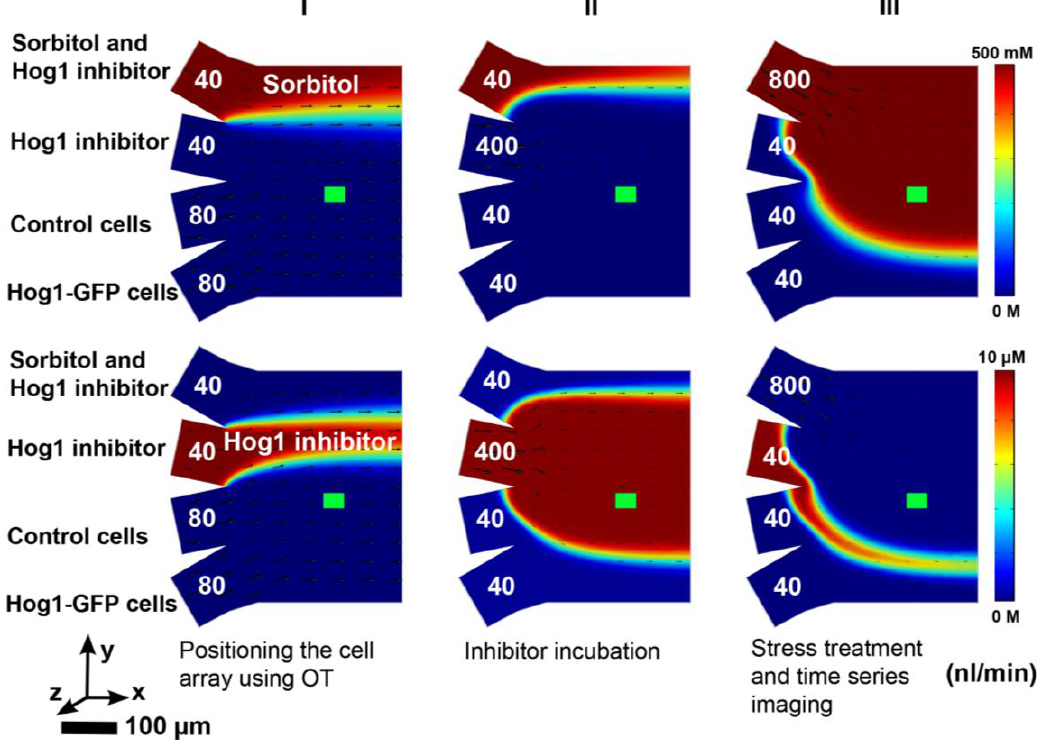
Figure 4. Simulation data on concentrations and flow velocities in the microfluidic chamber are shown. The arrow lengths are proportional to the flow velocities given at half of the channel height (a distance of 13.5 μm from the bottom surface). The concentration distribution is given at a distance of 0.1 μm from the bottom surface. The green area represents the position of the yeast cells and the pump rates are shown in nL/min for each inlet channel. The coloring represents the sorbitol flow from 0 to 500 mM ( upper row ) and the Hog1 inhibitor flow from 0 to 10 μM ( lower row ) respectively. The first configuration ( column I ) is used for positioning the cell array using OT, the second configuration ( column II ) is used for inhibitor incubation and the third configuration ( column III ) is used for sorbitol treatment and